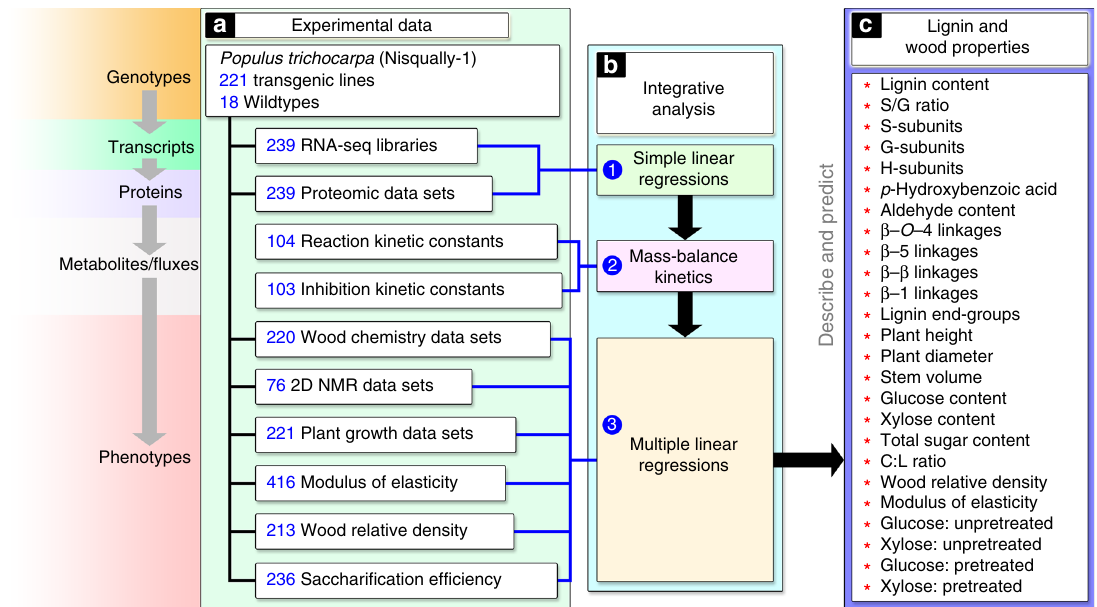
Fig. 2 Systematic integrative analysis of lignin biosynthesis in P. trichocarpa . a The experimental data measured for the transgenics and wildtype. b (1-3) The quantitative relationships between transcript and protein abundances are represented by simple linear regressions. Monolignol pathway metabolites and fl uxes are estimated using mass-balance kinetics. Multiple linear regressions associate the metabolite concentrations and fl uxes with lignin and